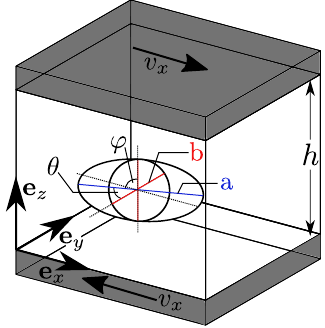
Figure 5. Sketch of validation test case with definition of half-axis and rotation angles as presented by Mueller